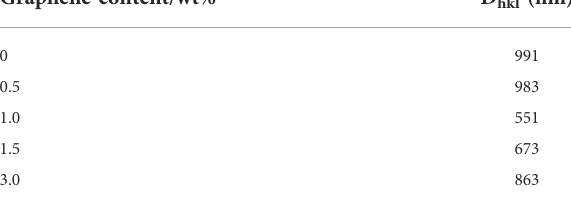
TABLE 2 Average grain degrees of Al 2 O 3 -G composites with different graphene contents. Graphene content/wt%